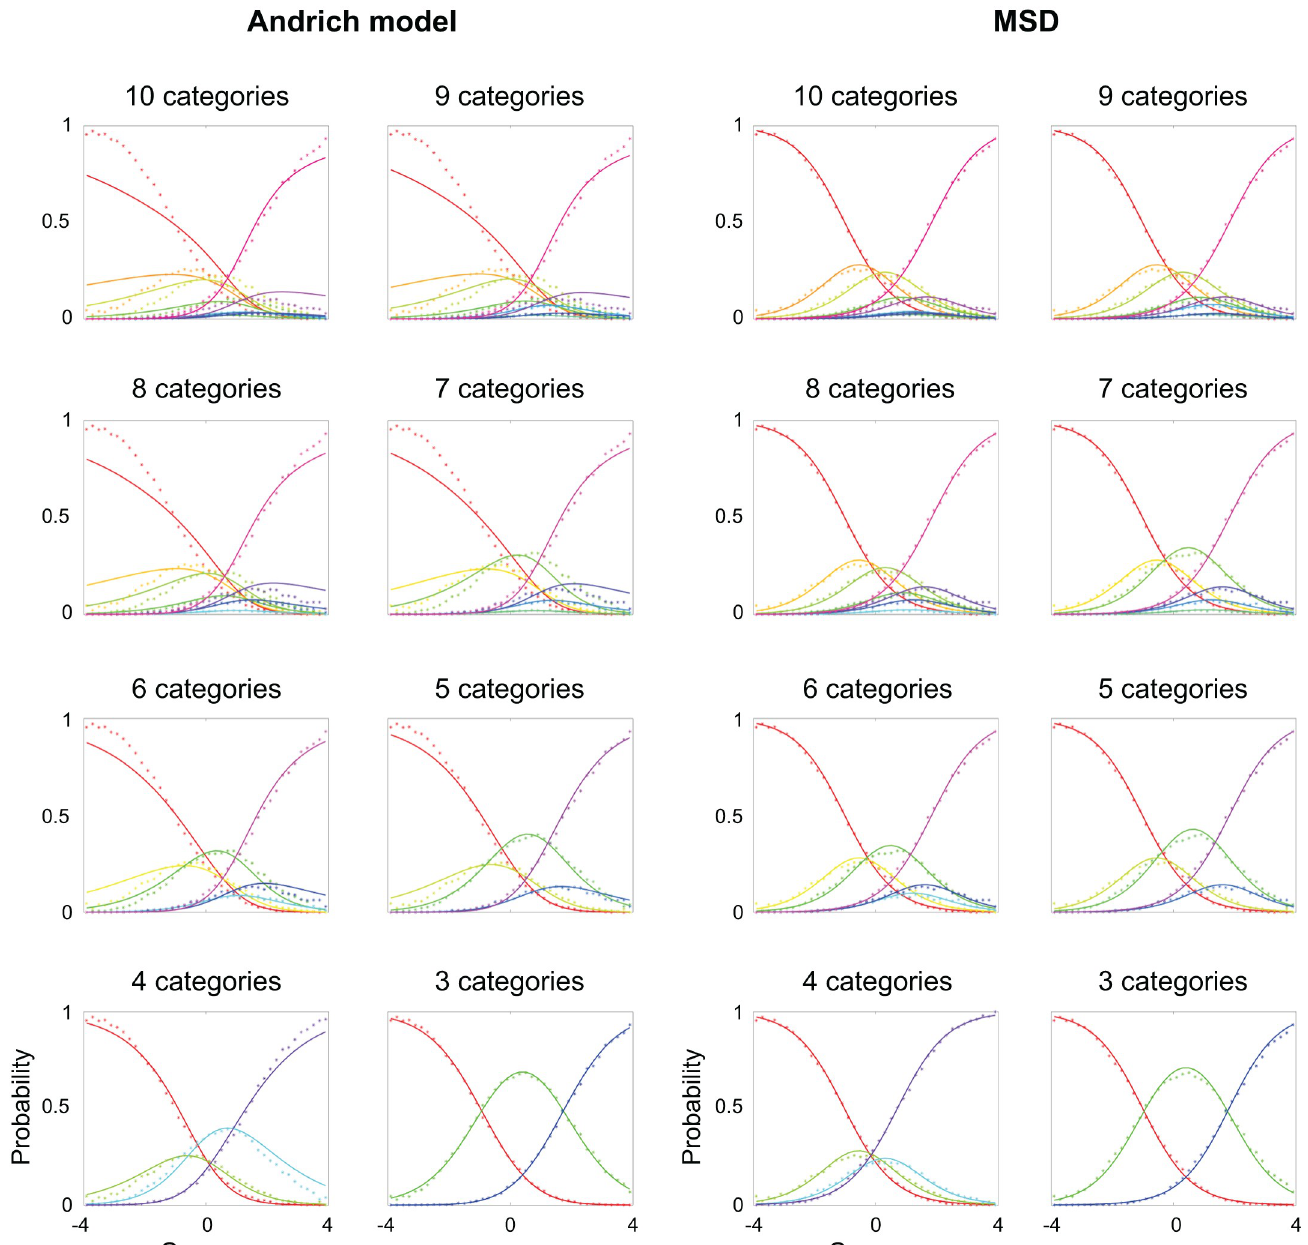
Fig 1. Comparing probability curves for the Andrich model and MSD. Actual frequencies (dots) of observing rating categories as a function of differences in true person and item measures, or gamma, compared to the predicted values (curves) from the Andrich model (left) and MSD (right). Binning of gamma was done for the simulated data in intervals of 0.2 logits. The Andrich model becomes less accurate than MSD the greater the number of rating categories.